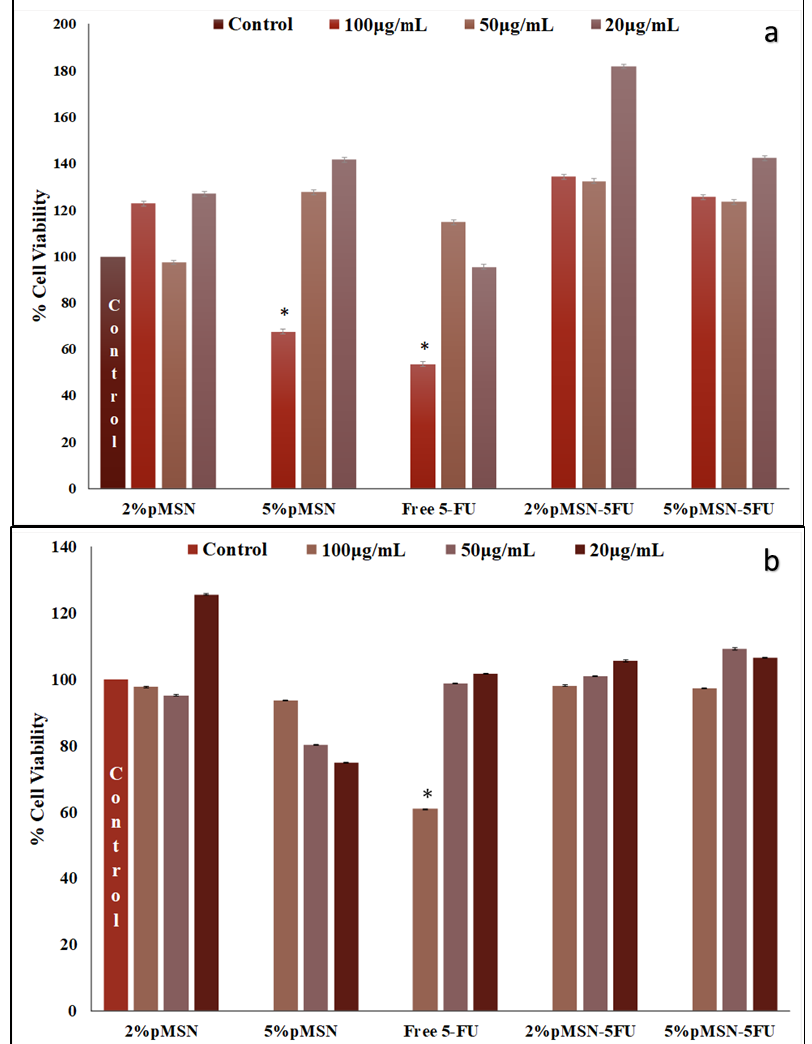
Figure 5. (a) 4,5-dimethylthiazol-2,5-diphenyltetrazolium bromide (MTT) and (b) sulforhodamine B (SRB) cell viability of f-MSNs and 5-FU-loaded MSNs administered at various concentrations (20, 50, and 100 μg/mL) in HEK293 cells . Data is represented as mean ± SD ( n = 3). * p < 0.05 was considered statistically significant.